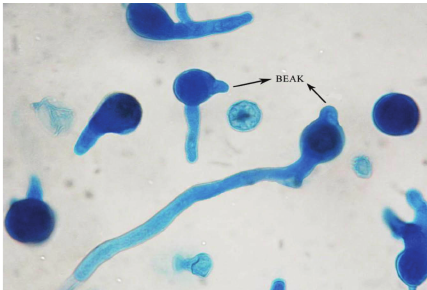
Figure 1: Lactophenol cotton blue preparation of Basidiobolus ranarum .